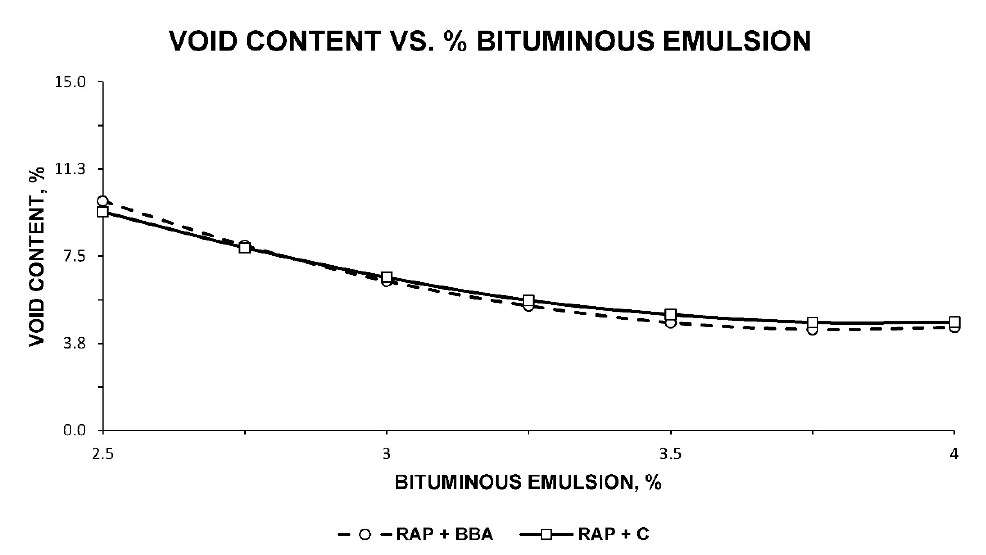
Figure 9. Graph of the results of the void content test, standard UNE-EN 12697-8, for bituminous mixtures made with RAP and BBA (RAP + BBA), as well as for bituminous mixtures with RAP and limestone aggregate (RAP + C).